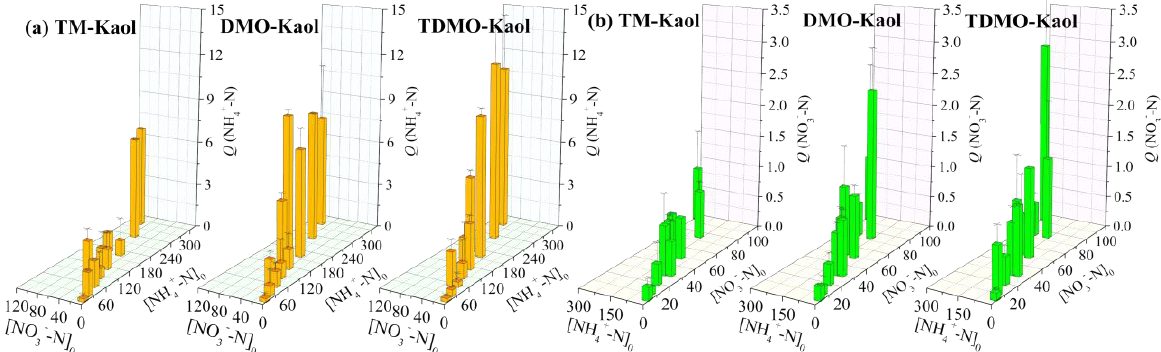
Figure 6. Influence of initial concentration on the adsorption of ( a ) NH 4+ − N and ( b ) NO 3 − − N using the grafted Kaol.